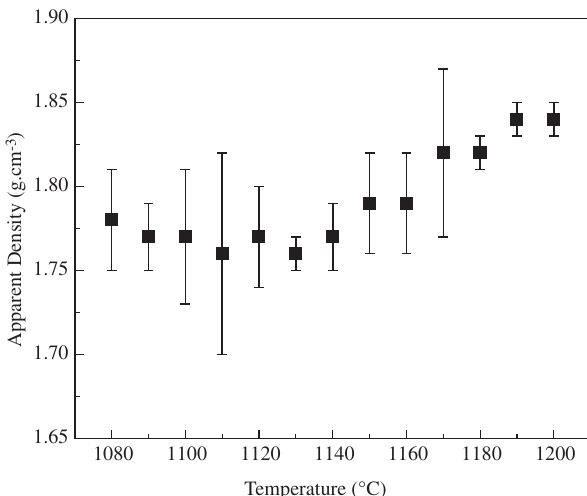
Figure 7. Apparent density as a function of sintering temperature.